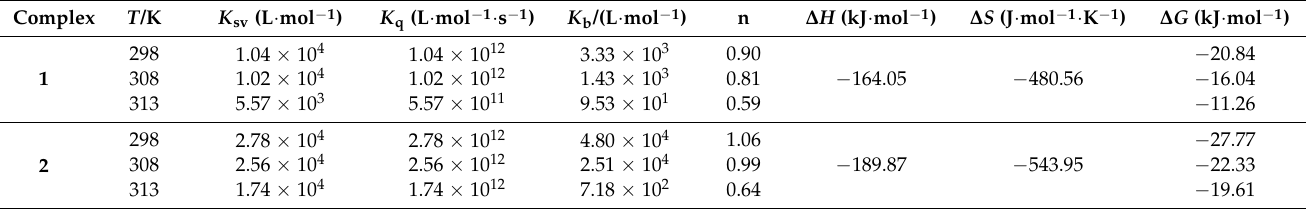
Table 5. K sv , K q , K b , n values, and thermodynamic parameters for complex-HAS systems at three different